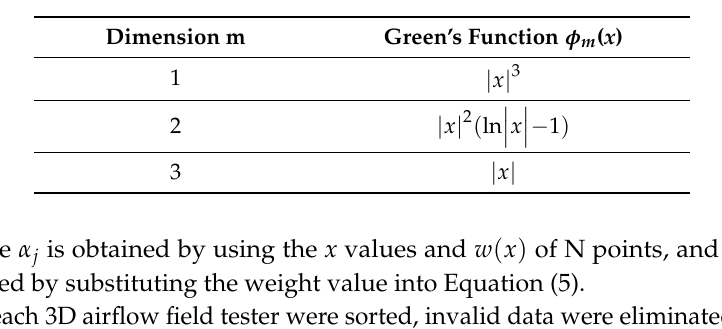
Table 1. Function in flat space.